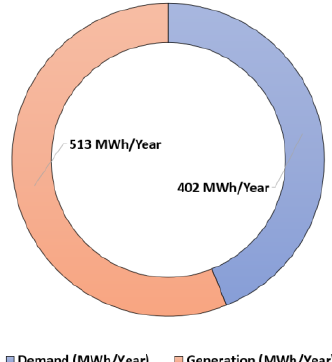
Figure 8. REC’s estimated consumption and generation chart.